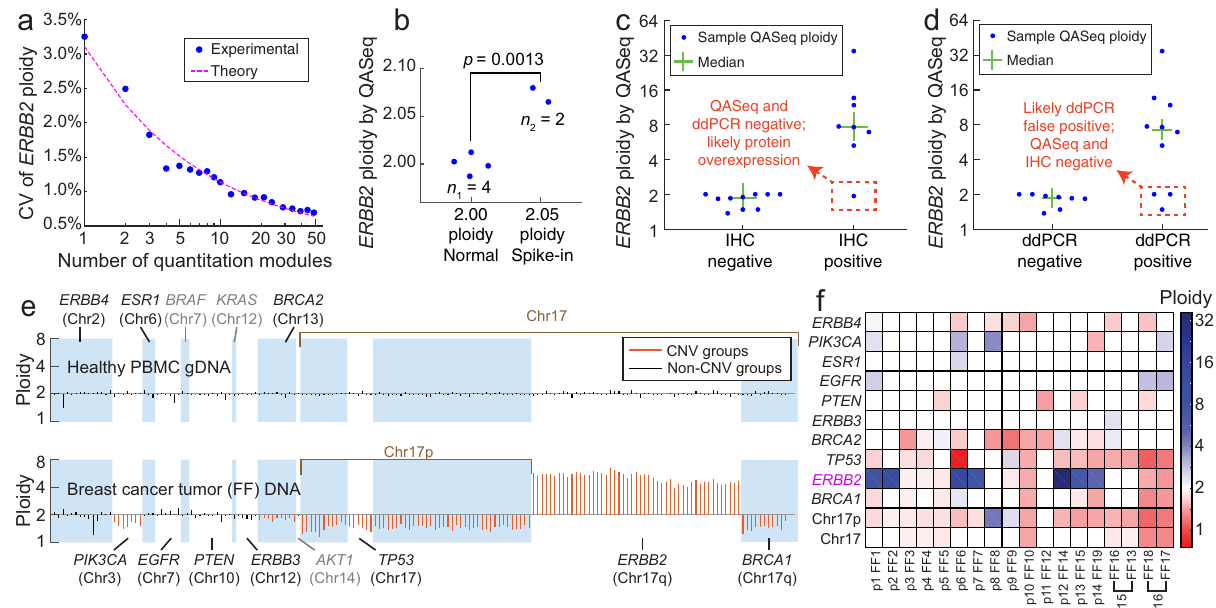
Fig. 2 Combination of multiple absolute quantitation modules for CNV detection. a Stochastic error in copy number quantitation was reduced by increasing the number of quantitation modules in the gene. ERBB2 ploidy was calculated as 2 times the ratio between the mean of UMI family counts from modules in ERBB2 and in the reference. Because there are multiple possibilities of module down-selection, here each datapoint represents the average of 30 randomized selections. 123 modules served as the reference for ploidy calculation. The CV of 1 module was lower than that in Fig. 1d, because only 1 module was used for both the reference and ERBB2 . b Discriminating 2.05 and 2.00 ploidy ERBB2 samples using QASeq. The P -value calculated using